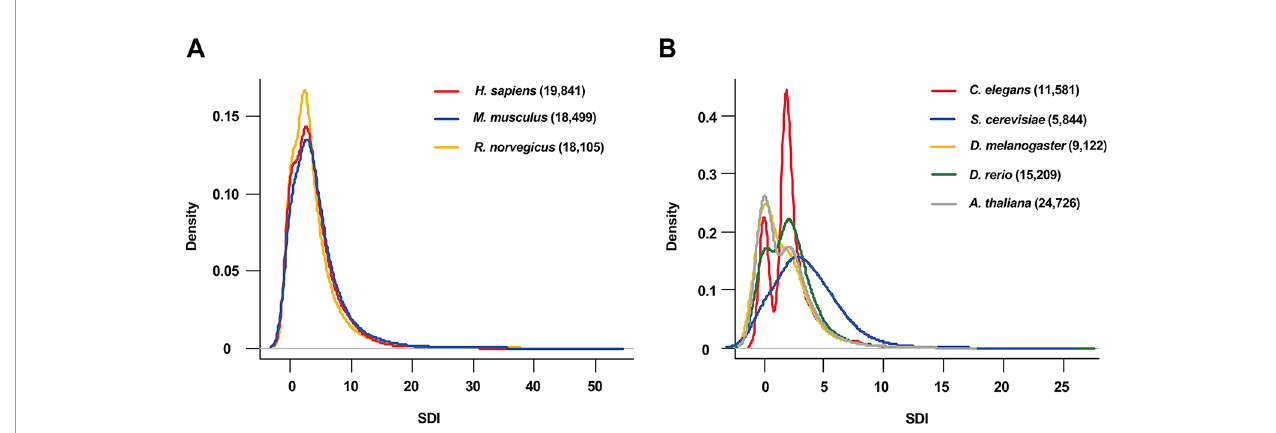
FIGURE 1 | The distribution of SDI in eight species. The density plots show the distribution of SDI in thee mammals (Bandwidth = 0.9134) (A) and 5 other species (Bandwidth = 0.4149) (B) . Gene number for each species is presented in the brackets. C.elegans has a larger proportion of genes with two GO-CC terms than other species which may lead to its bimodal distribution ( Table S2 ). SDI, Subcellular Diversity Index; GO-CC, Gene Ontology-Cellular